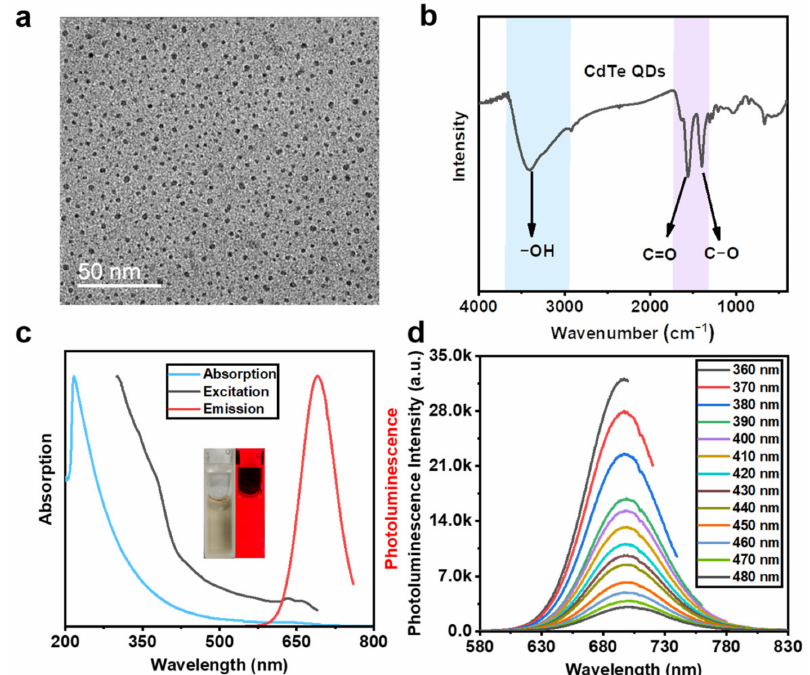
Figure 2. ( a ) TEM image and ( b ) FTIR spectrum of CdTe QDs. ( c ) Absorption (blue), excitation (black), and emission (red) spectra of CdTe QDs. Insets show the solution pictures of CdTe QDs under natural light (left) and 365 nm UV light (right). ( d ) Excitation wavelength-dependent photoluminescence spectra of CdTe